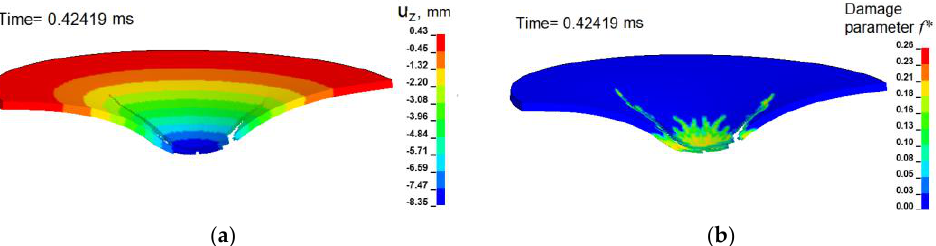
Figure 10. ( a ) Calculated distribution of displacements u z in the cross-section of a punched Ti-5Al-2.5Sn plate at the time of 0.42419 ms; ( b ) is the distribution of the damage parameter in the cross-section of a punched plate. The velocity of the punch is 15 m/s.